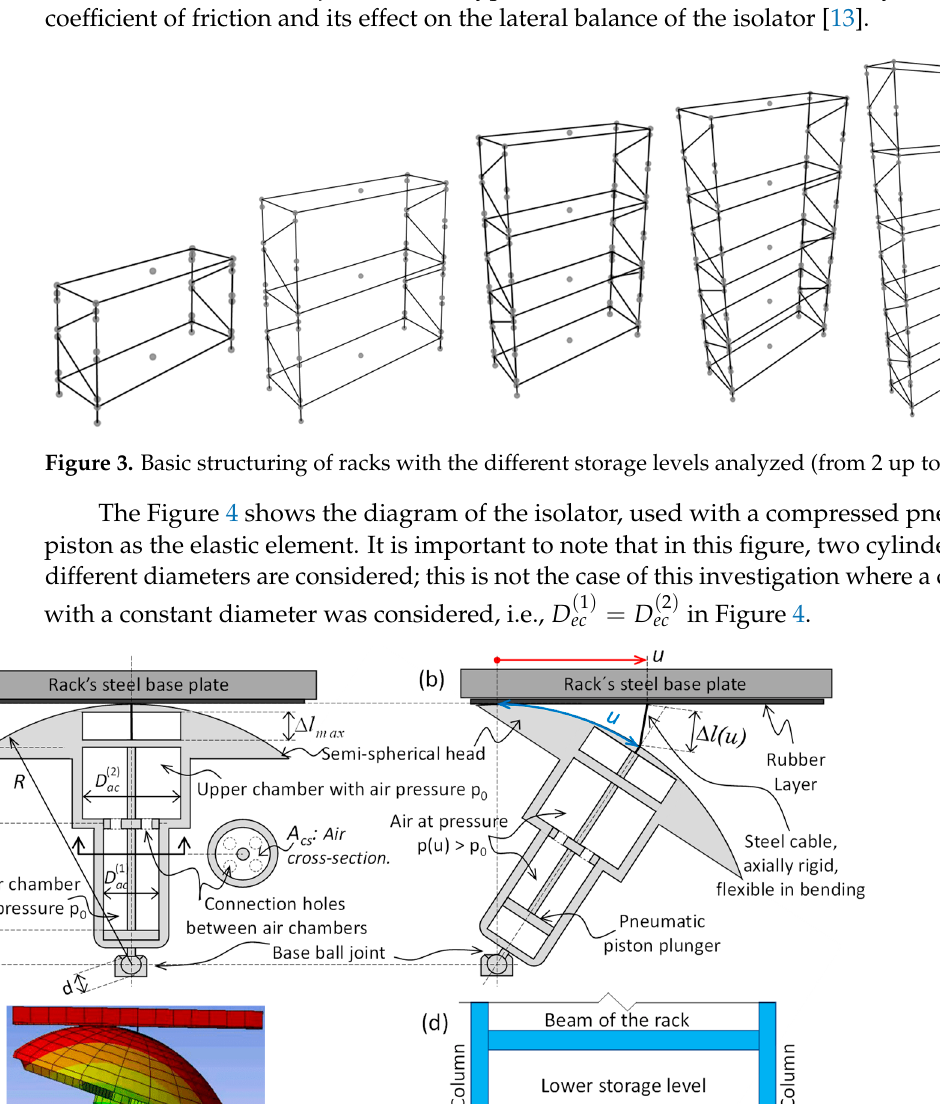
sition, ( b ) deformed position with maximum displacement, ( c ) Three-dimensional scheme of the finite elements model of the